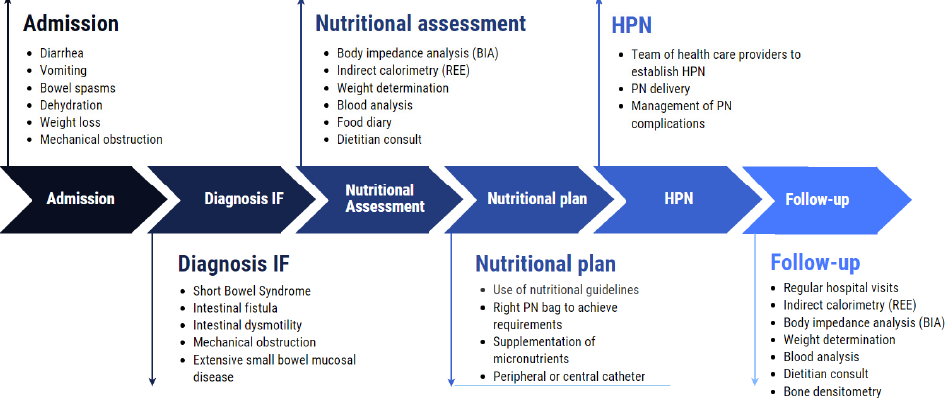
Figure 1. Different steps, from hospital admission to discharge and follow-up with HPN. Protocol used in UZ Brussel. used in UZ